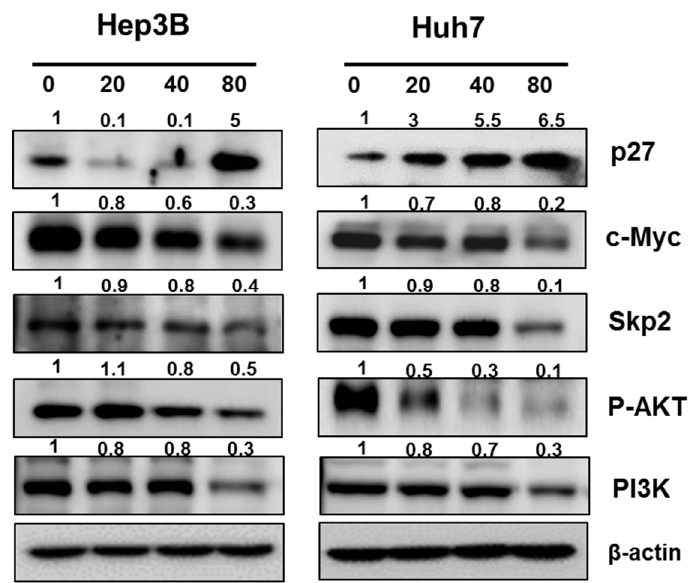
Figure 4. Pyrogallol modulated the expression of p27, c-Myc, Skp2, p-AKT and PI3K in Hep3B and Huh7 cells.